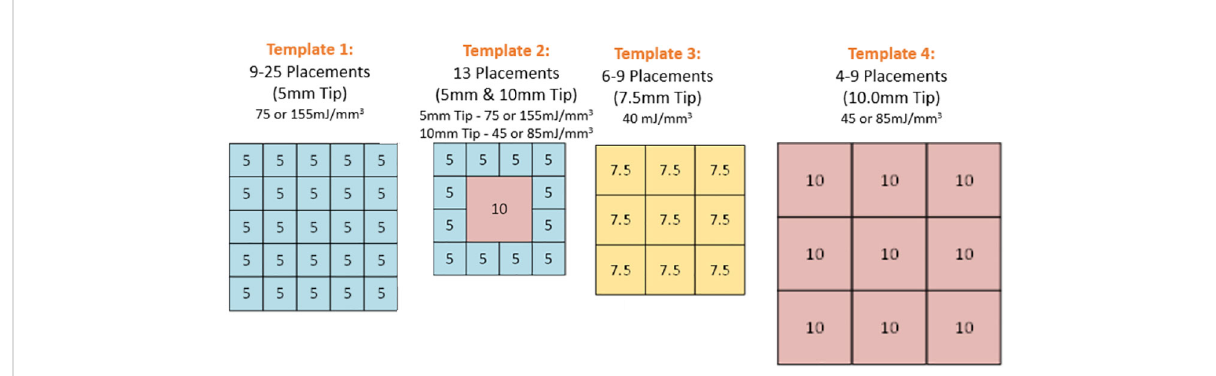
FIGURE 1 Templates used to guide applicator tip placement over BCCs.